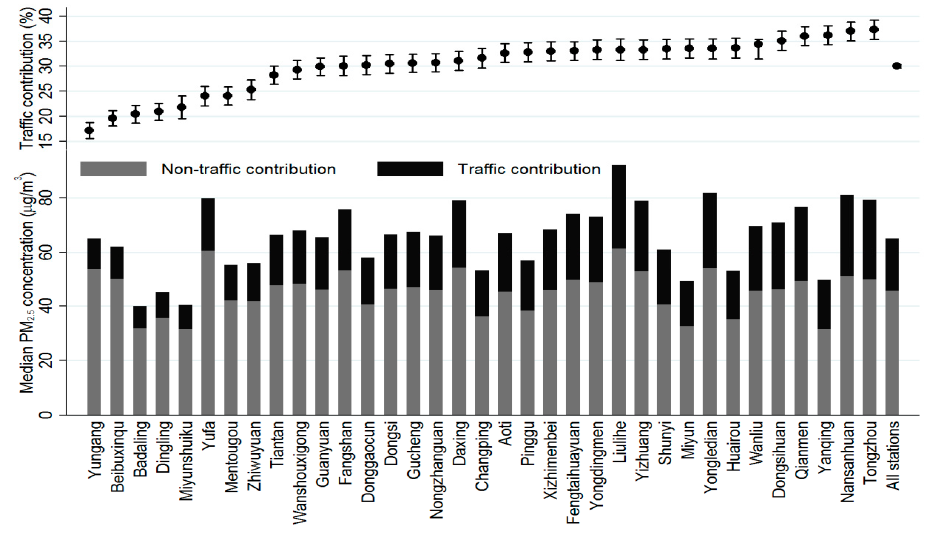
Figure 6. Contribution (%) of road traffic to median PM 2.5 concentrations by stations in Beijing, 2013–2014.